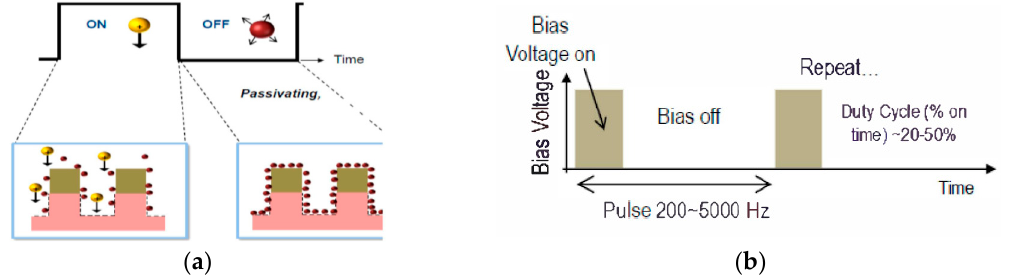
Figure 12. ( a ) Bias pulsing power effect and ( b ) Bias pulsing process. Reproduced with permission from [121]. Copyright IEEE, 2015.